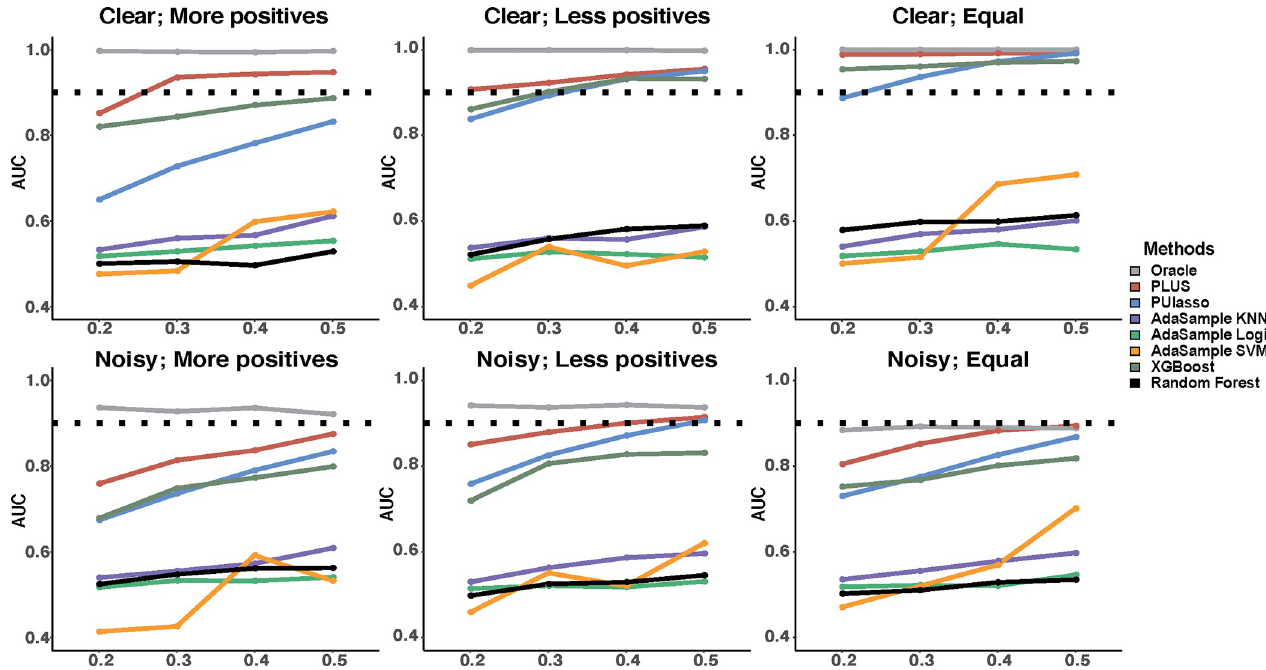
Fig 2. Performance comparisons of the competing methods on simulated data. The top panel shows results for simulation settings in which the positive and negative sets are clearly separable, while the bottom panel shows results for simulation settings in which the two sets are less separable. The left-most column shows results for simulation settings in which there are more true positive samples than true negative samples, the middle column shows results for less true positive samples than true negative samples, and the right-most column shows results for an equal number of true positive and negative samples. The dotted line corresponds to an AUC of 0.9. Here, the y -axis represents the AUC. And x -axis shows levels of observation unbalancedness, where a larger number indicates that the number of observed positive samples is closer to that of the unlabeled samples, with 0.5 indicating that the numbers are equal.